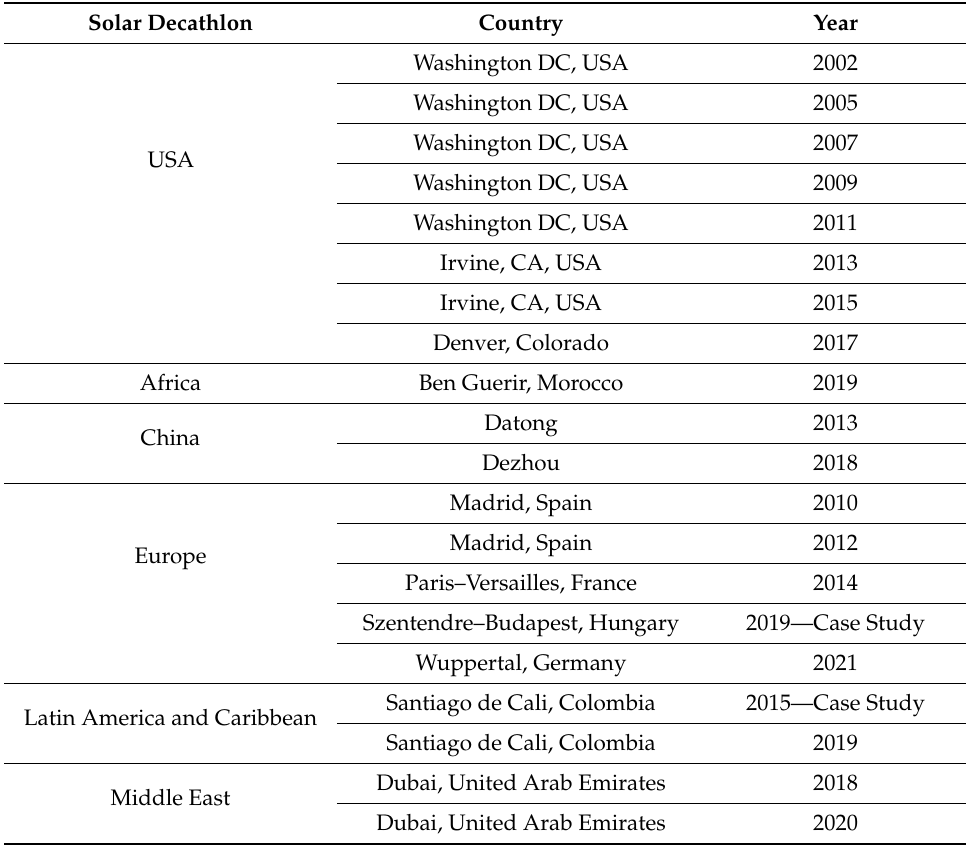
Table 2. Timeline of editions of the Solar Decathlon